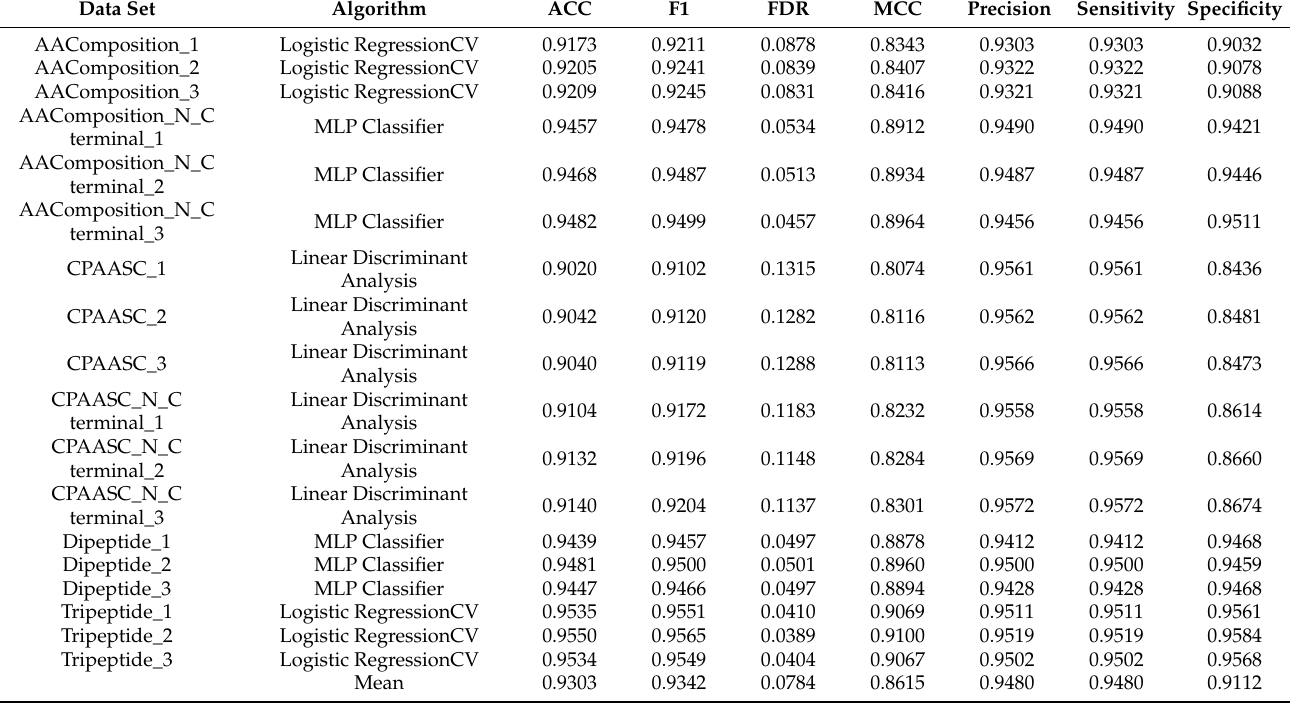
Table 3. Summarized results of the evaluation models built with the RLPs/NRLPs datasets.